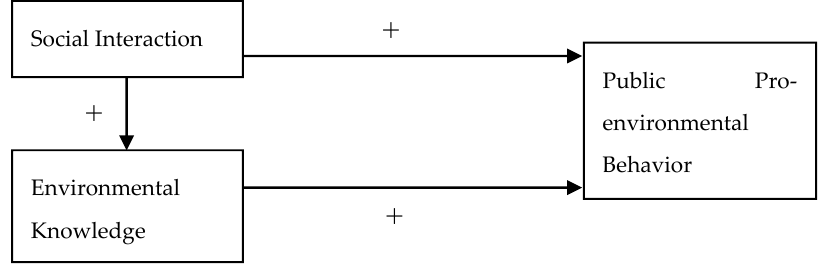
Figure 1. Conduction path.